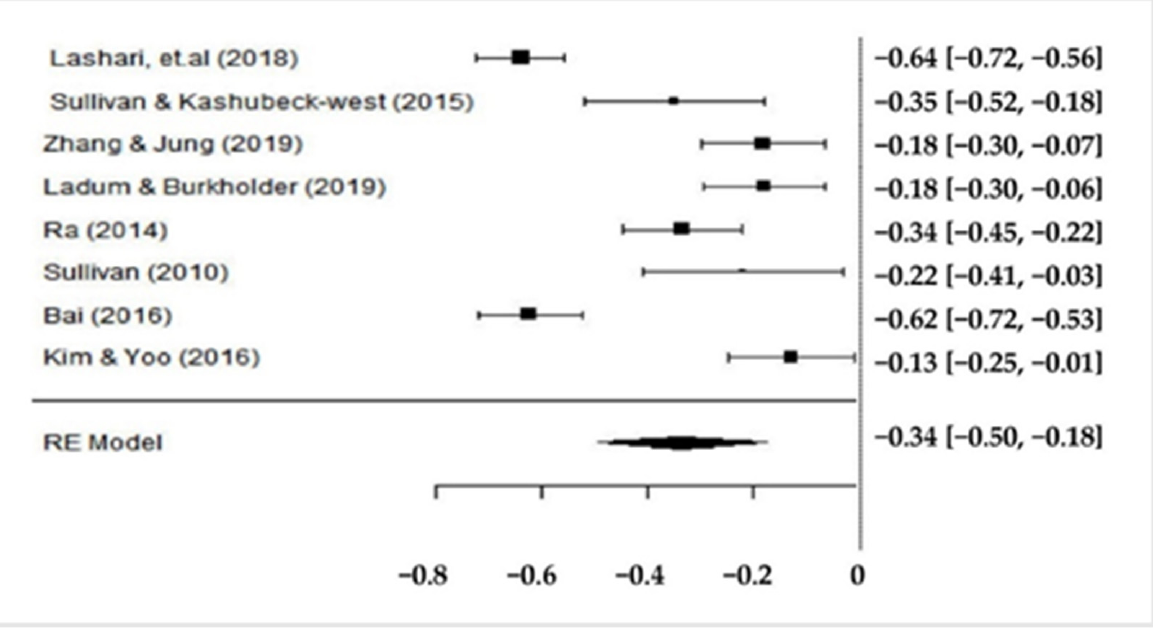
Figure 2. Forest plots comparison of the studies in the meta-analysis.